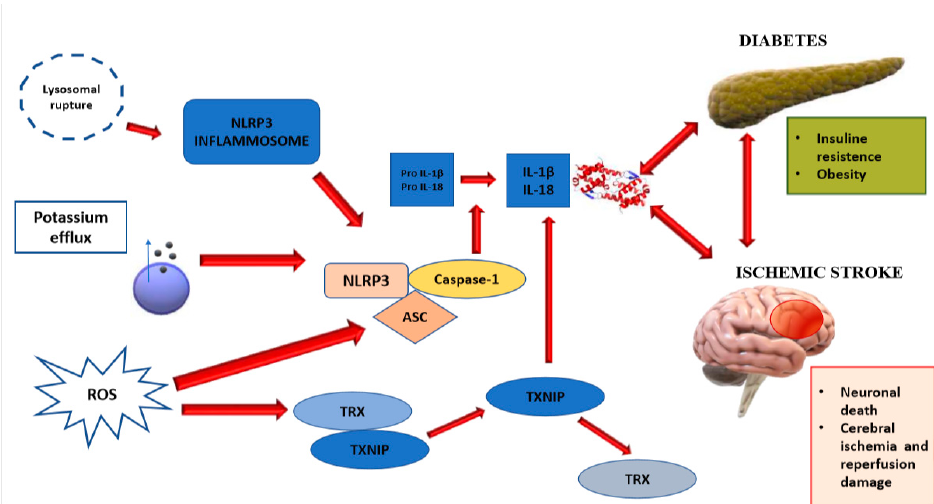
Figure 1 . The NLRP3 inflammasome plays a fundamental part in the process of neuroinflammation consequent to a cerebrovascular accident, particularly in diabetic patients in which enhances the progression of metabolic disorder. The figure above illustrates three hypothetic etiopathogenetic factors such as lysosomal rupture, ROS and cellular potassium efflux, which are co-responsible of the activation of caspase 1, triggering the release of mediators of inflammation like cytokines IL-18 and IL-1 β . In the macrophages of adipose tissue, the activation of NLRP3 inflammasome is determined by the release of DNA and the production of ROS in mitochondria, through the desegregation of TRX-TXNIP complex. After its triggering, NLRP3 inflammasome provokes the cleavage of pro-IL-1 β into IL1-1 β , the active form, and the release of IL-18. These cytokines phosphorylate IRS-1, as known as the insulin receptor substrate-1, worsening insulin- resistance and causing neuronal death.